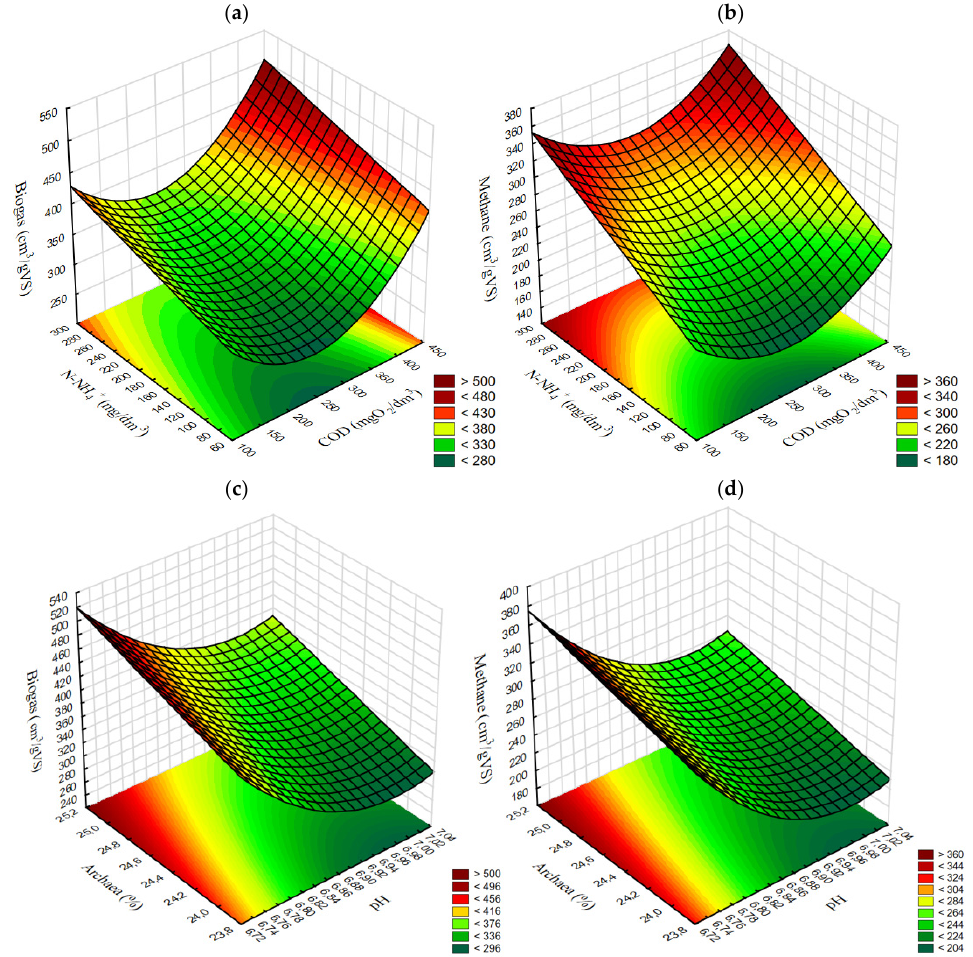
Figure 9. Surface correlation between COD and N-NH 4 concentrations and the yields of ( a ) biogas and ( b ) methane; and between pH and Archaea contribution in the population of methanogens and the yields of ( c ) biogas and ( d ) methane.